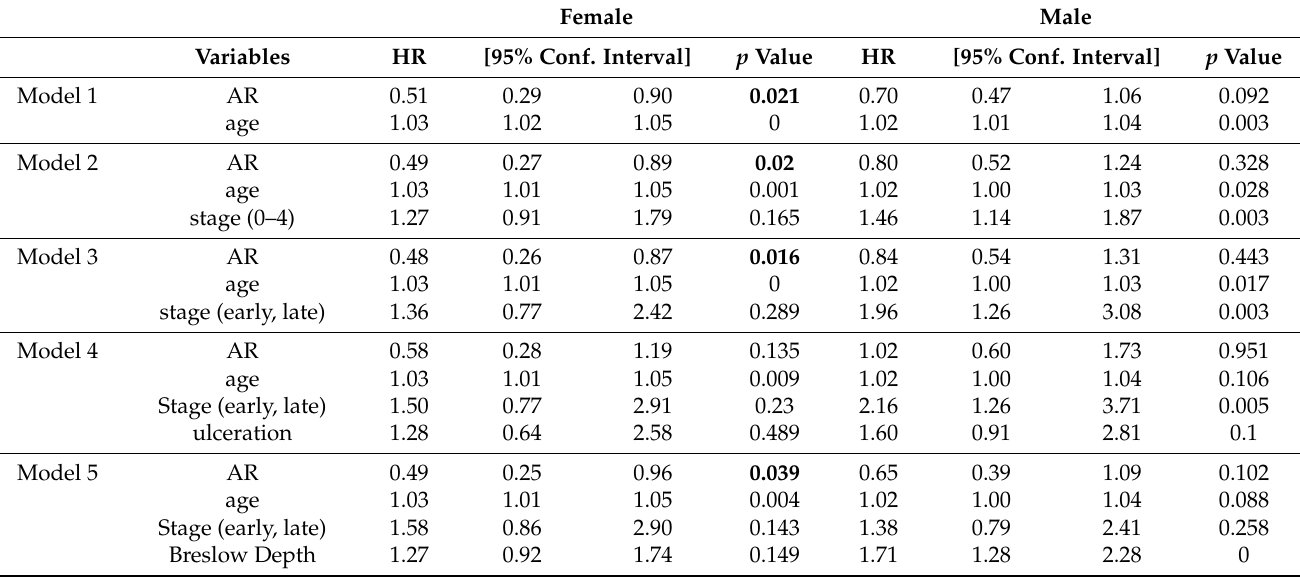
Table 4. AR protein level for survival between female and male